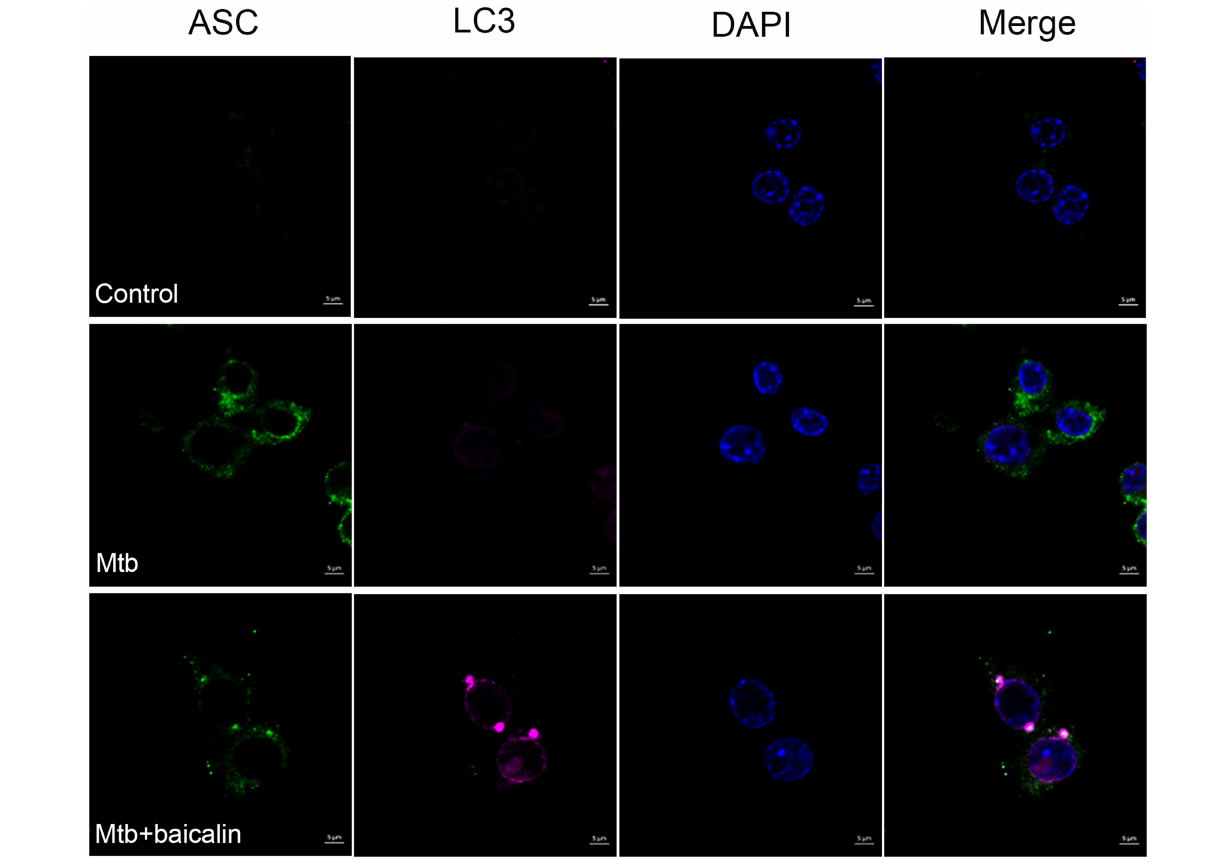
FIGURE 11 | Baicalin promotes co-localization of inflammasome with autophagosome. Confocal microscopy of Raw264.7 cells with different treatments immunostained with anti-LC3 antibody (pink), anti-ASC antibody (green), and DAPI (blue). Scale bars shown are 5 µ